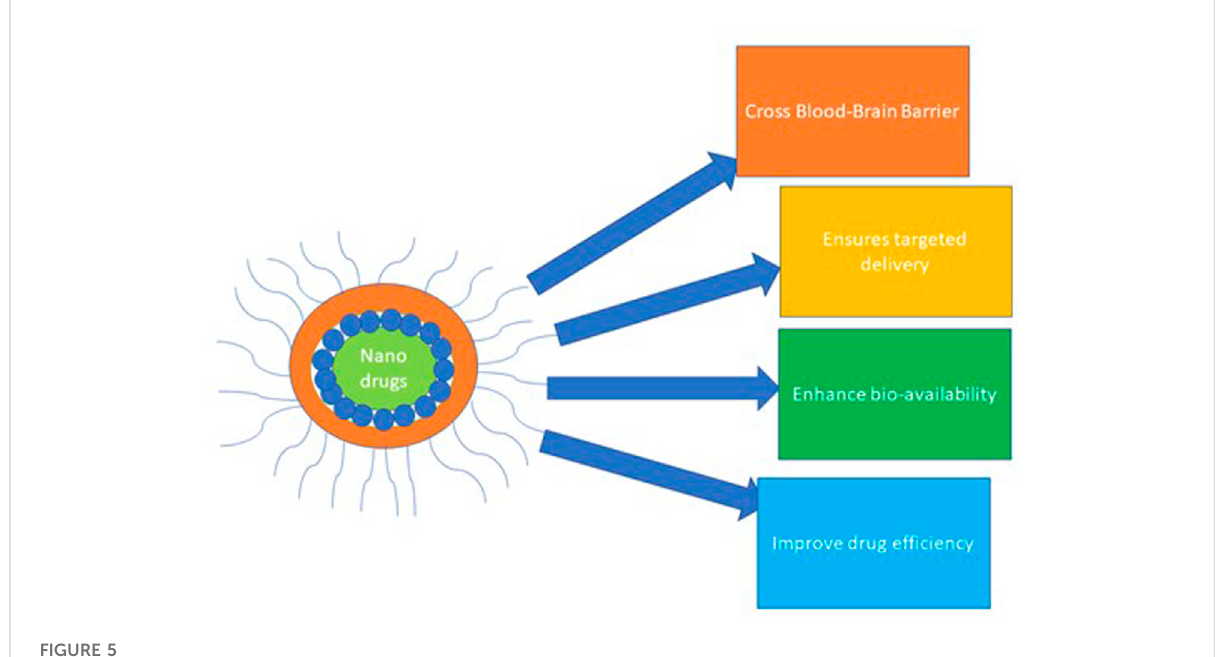
FIGURE 5 Nanoparticle conjugated drugs in the drug delivery